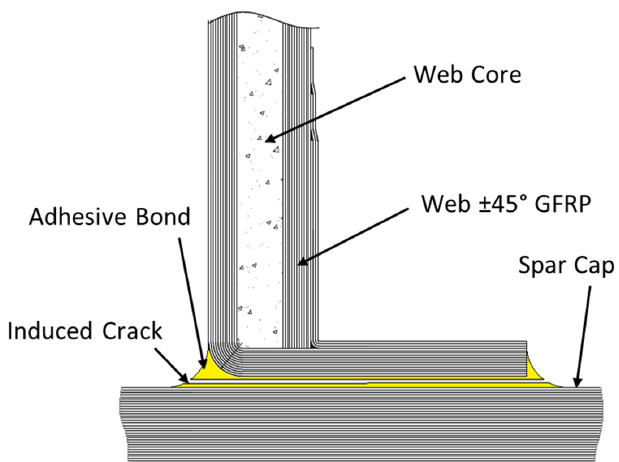
Figure 1. Schematic of induced crack location.